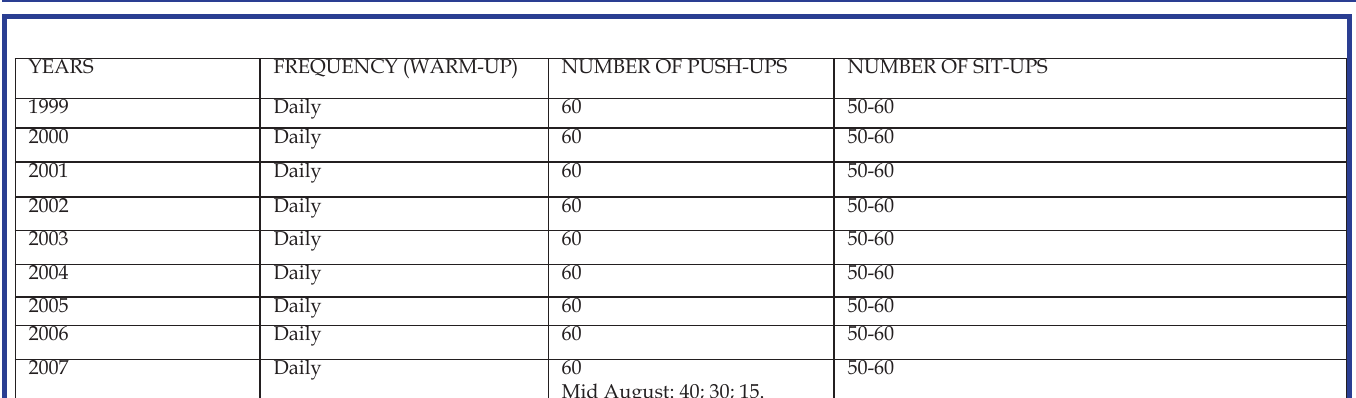
Table 3: Warm-up